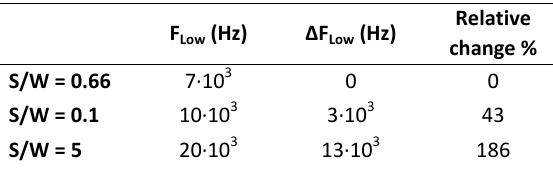
Fig. 12b: Behavior of corresponding electrical phase by varying the ratio between width of electrodes and gap. Table 1: Representative table of the variation of cut off frequency F Low depending on the